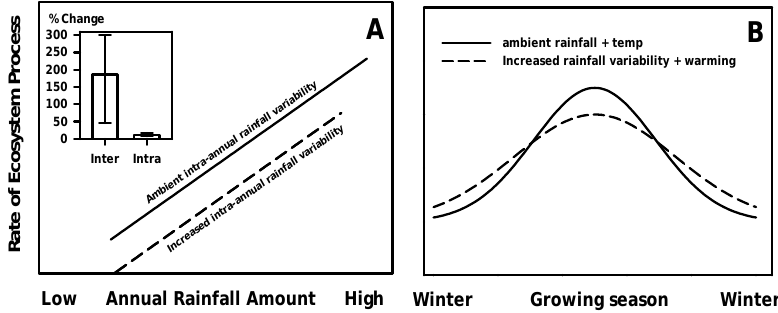
Fig. 9. Conceptual model of the coupled effects of (A) Annual rainfall amount and increased intra-annual rainfall variability, showing here the simplest case of a linear relationship of ecosystem function with rainfall amount for this ecosystem, and (B) increased intra-annual rainfall variability and warming on ecosystem processes. The inset shows the mean and range of the % change in four primary ecosystem processes (aboveground net primary productivity, midseason aboveground biomass, A CO (increased rainfall variability)